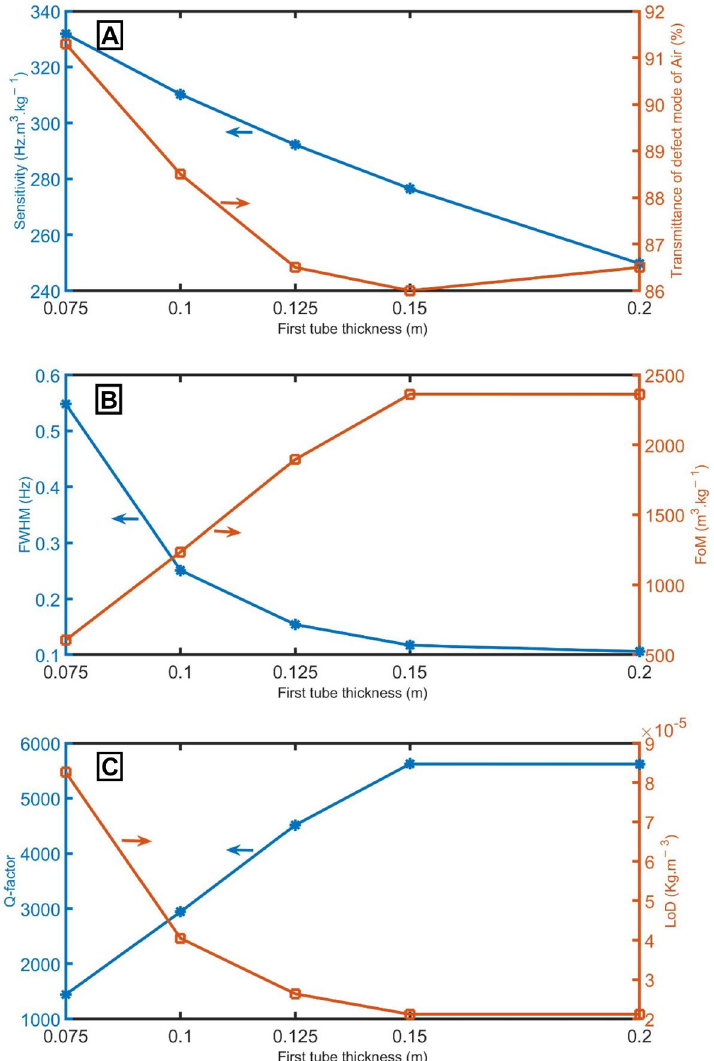
Figure 4. ( A ) sensitivity between air and pure CH 4 samples and transmittance of the resonant mode of air samples, ( B ) FWHM of the resonant mode of air samples and FoM , and ( C ) Q-factor and LoD of the proposed gas sensor at different values of first tube thickness of the unit